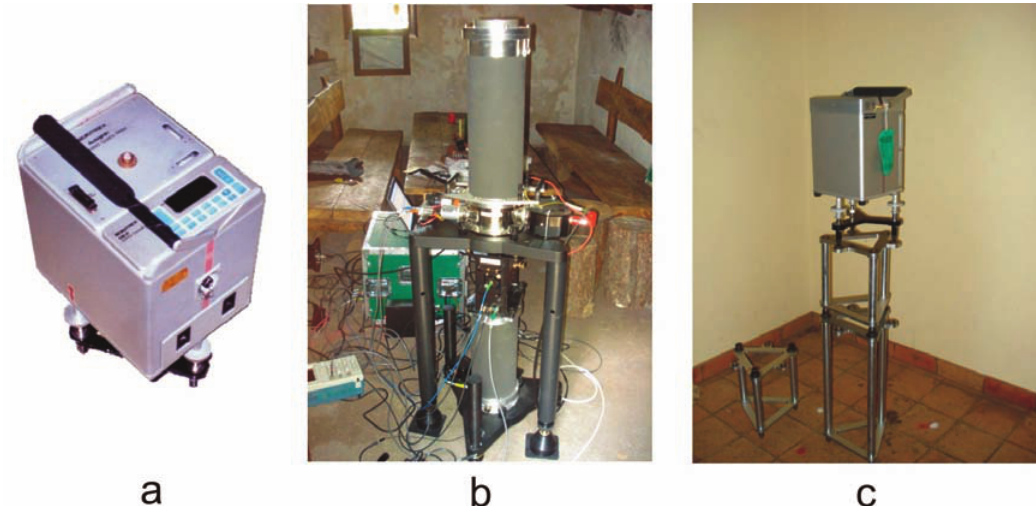
Figure 2. Gravimeters used at Mt. Etna volcano: (a) CG-3M#9310234 Scintrex relative gravimeter; (b) FG5#238 Micro-g LaCoste absolute gravimeter; (c) CG5#8664.196 Scintrex relative